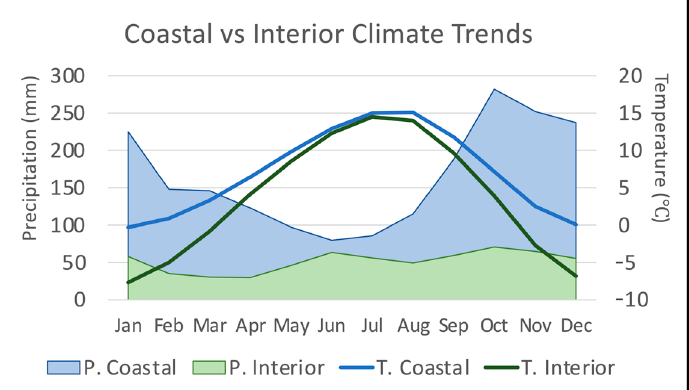
Figure 2. Contrasting mean monthly precipitation (shaded areas) and temperature (lines) of the interior and coastal sub-basins for the period 1981–2010 as derived from climate data [19].